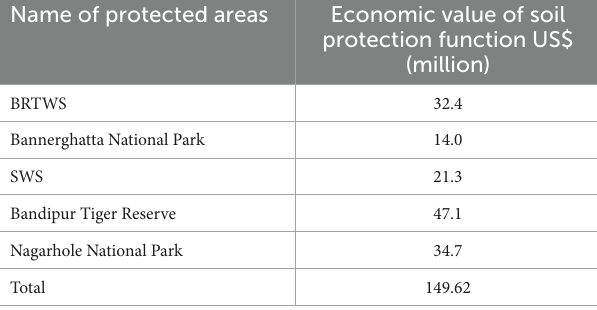
TABLE 4 Economic value of soil protection